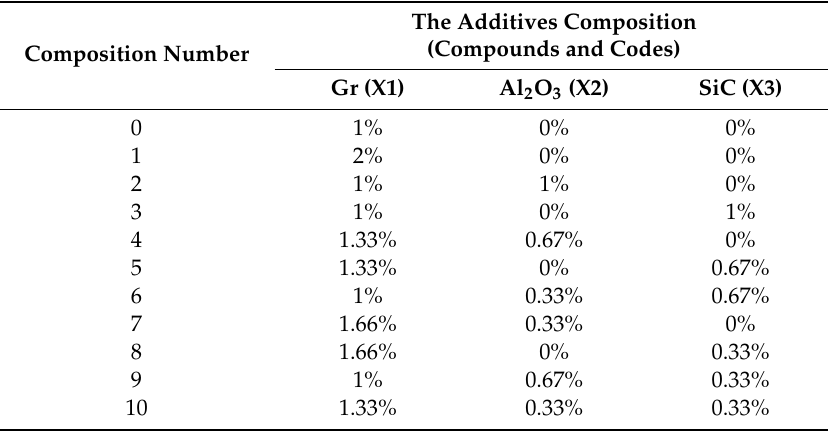
Figure 1. Al 2 O 3 ( a ) and SiC ( b ) clusters. Table 1. The compositions of metal-matrix composites (MMCs) studied.